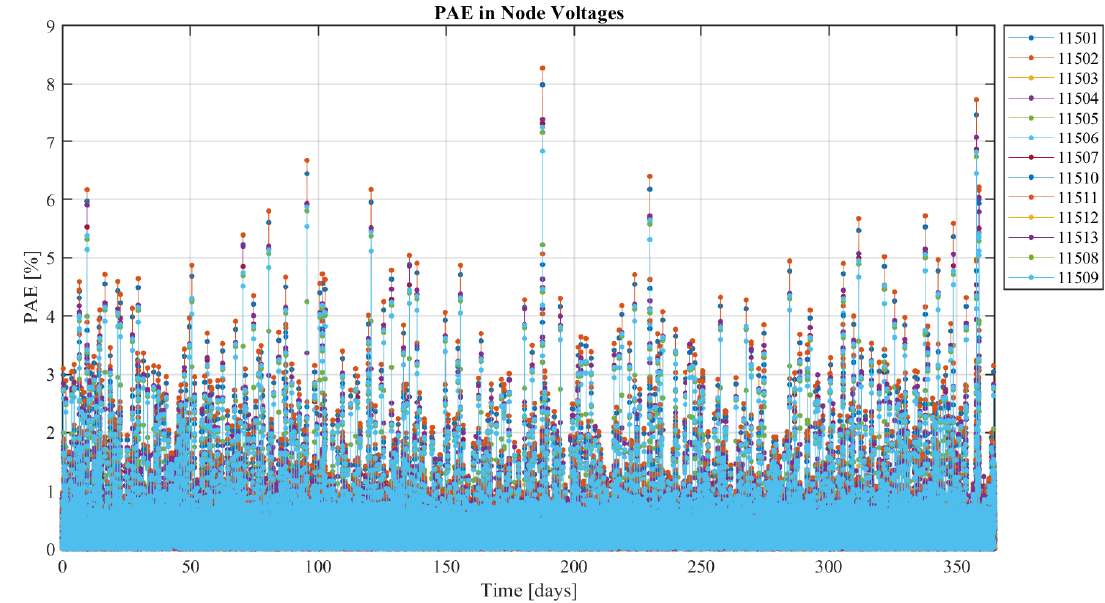
Figure 11. Plot of PAE for the simulation of DSSE with multiple